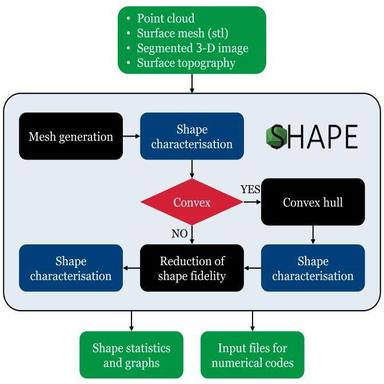
Main architecture of SHAPE.